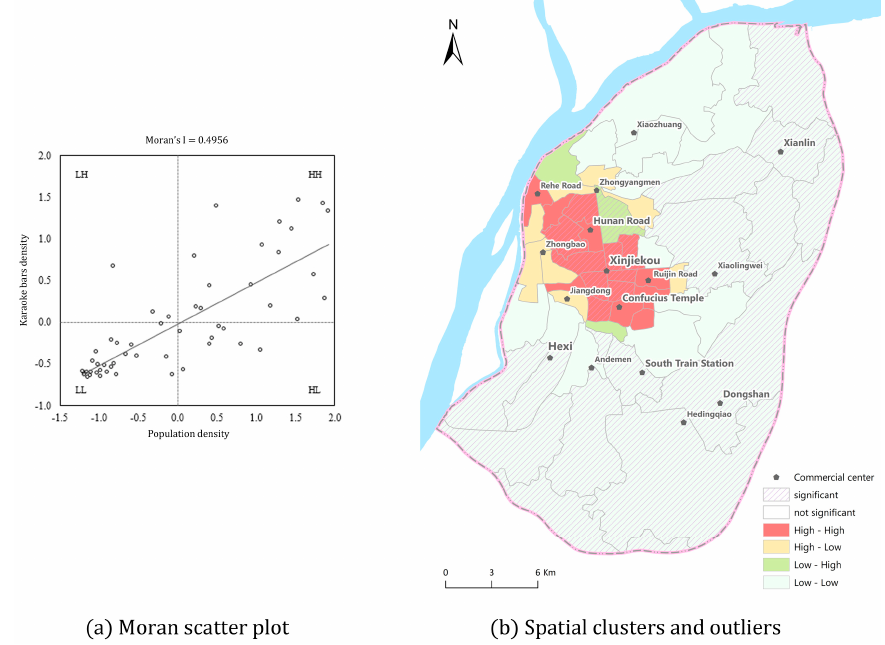
Figure 8. Spatial correlation between population density and karaoke bars: ( a ) Moran scatter plot; ( b ) Spatial clusters and outliers.